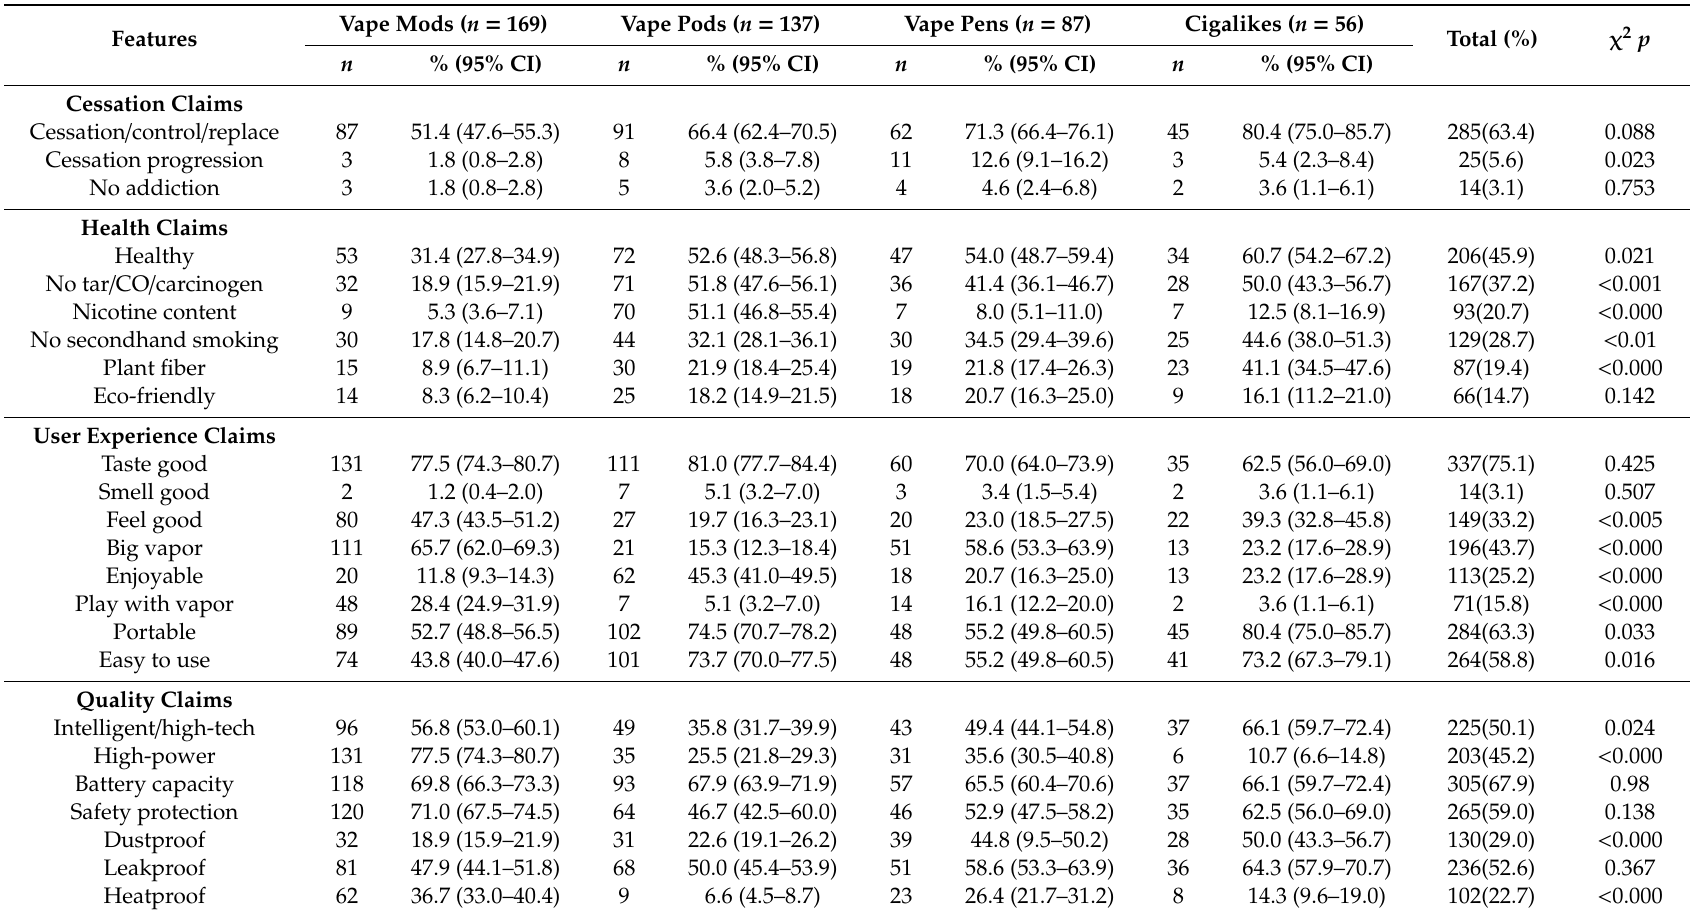
Table 2. Content features of online advertisements by e-cigarette